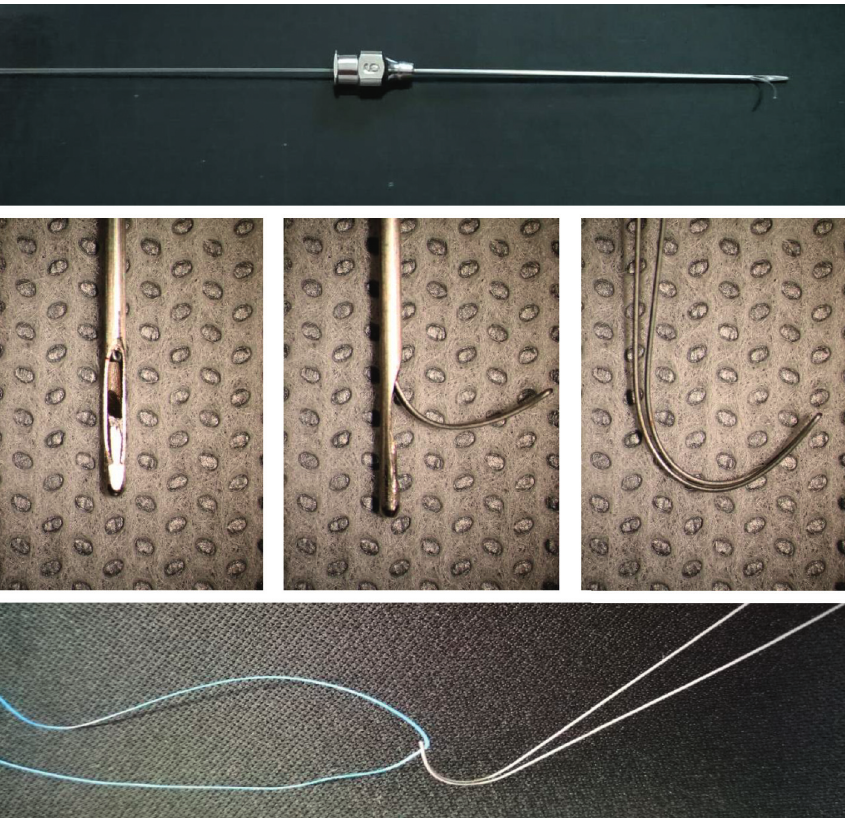
Figure 2: Memory wire probe consists of a stainless steel syringe needle probe with its memory wire inside. The syringe needle probe has a closed round tip and a side port which allows the memory wire in and out. The memory wire is made of two strands with a joint head, allowing it to clip the nylon